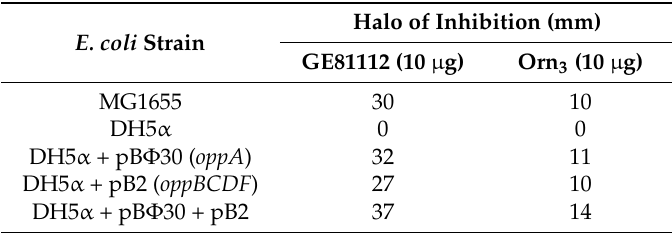
Table 4. Effect of genes of the opp operon on the sensitivity to GE81112 and tri- L -ornithine of E. coli DH5 α .